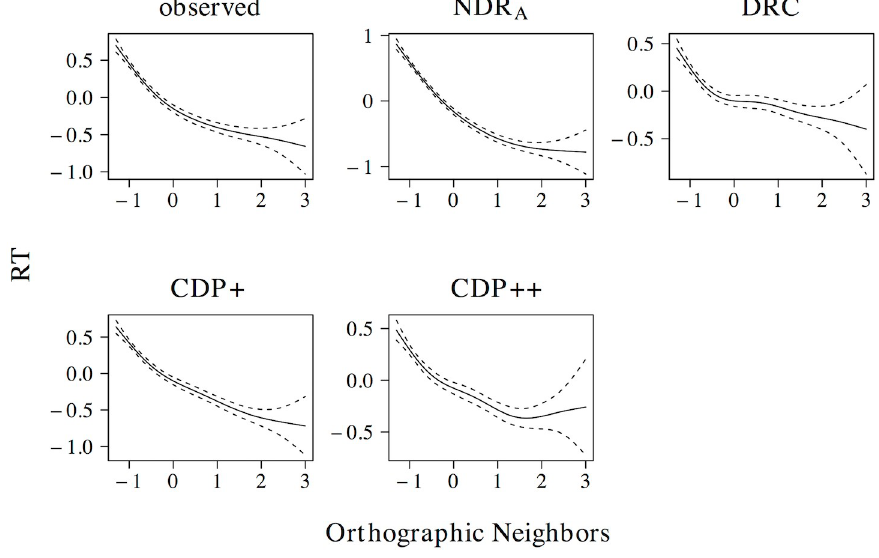
Fig 6. Orthographic neighborhood density. The effect of orthographic neighborhood density in word